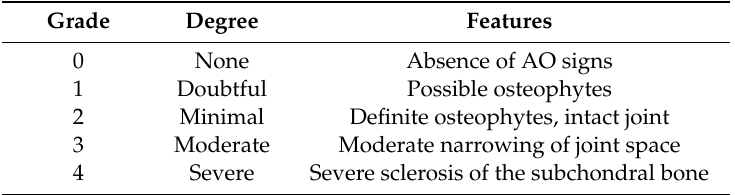
Table 1. Kellgren and Lawrence system for classification of osteoarthritis (OA). Grade Degree